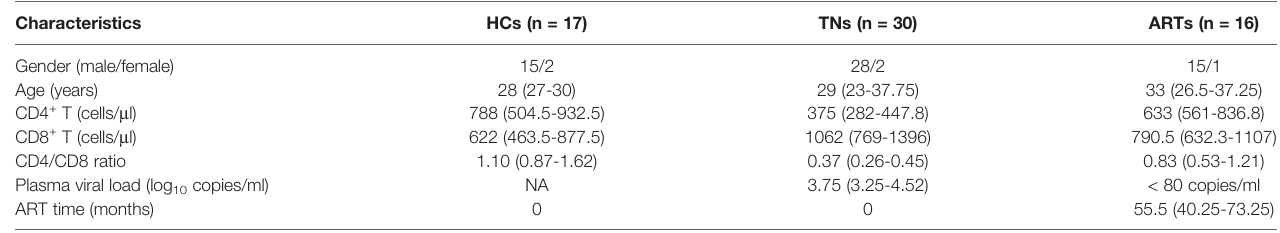
TABLE 1 | Demographic characteristics of the participants for blood samples.